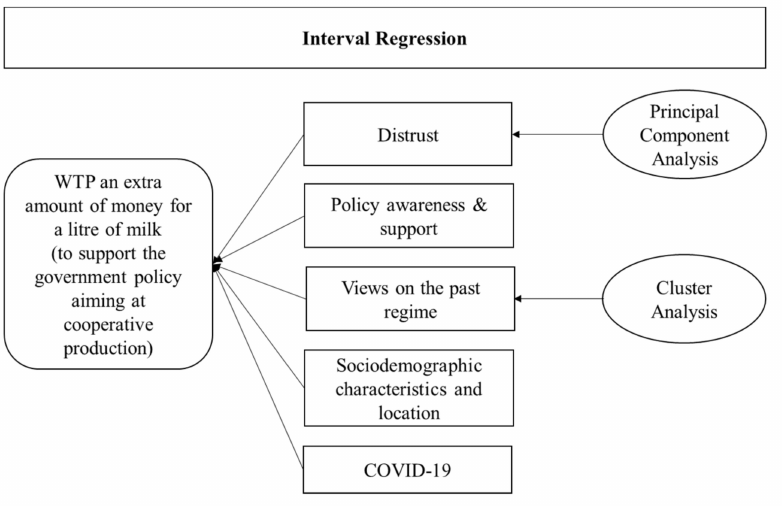
Figure 2. The conceptual framework of the